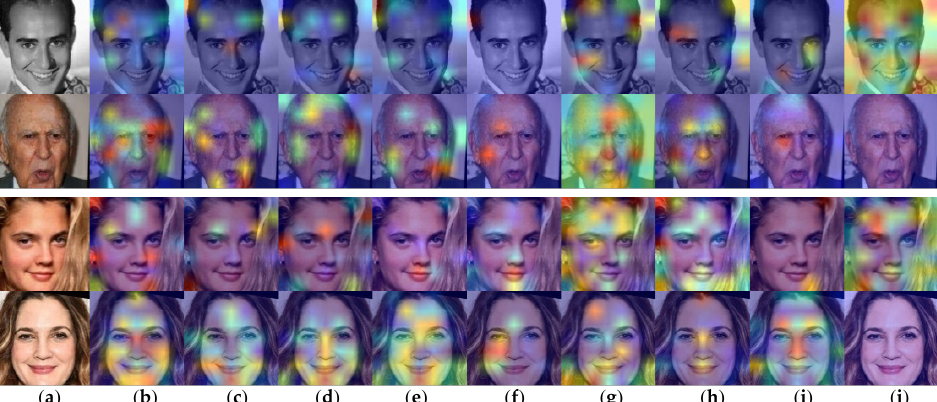
Figure 10. Two random face image pairs from the CALFW dataset. The original image pairs are shown in ( a ), and the corresponding Grad-CAM visualisations for ConvFaceNeXt family members are illustrated from ( b ) to ( e ), while those for the other previous works are shown from ( f ) to ( j ), with all arranged column-wise from left to right. ( a ) Original face image pairs. ( b ) ConvFaceNeXt_PS. ( c ) ConvFaceNeXt_PE. ( d ) ConvFaceNeXt_TS. ( e ) ConvFaceNeXt_TE. ( f ) MobileFaceNet [11]. ( g ) Shuf- fleFaceNet 1 × [12]. ( h ) ShuffleFaceNet 1.5 × [12]. ( i ) MobileFaceNetV1 [13]. ( j ) ProxylessFaceNAS